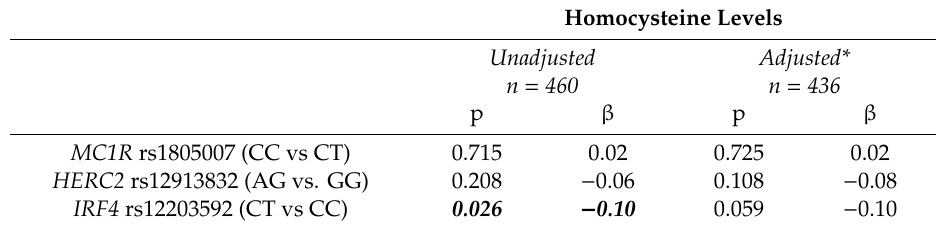
Table 7. Association between skin pigmentation genetic variants and homocysteine levels, with and without adjustments for homocysteine determinants.